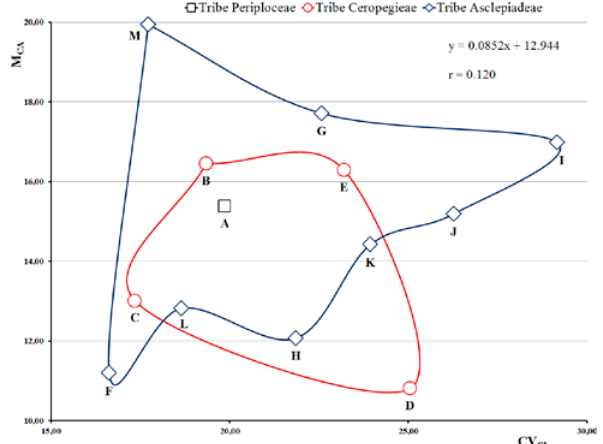
Figure 5. Scatter diagram between M CA and CV CL : Periploca angus- tifolia (A), Caudanthera edulis (B), Caudanthera sinaica (C), Desmi- dorchis acutangulus (D), Leptadenia arborea (E), Glossonema bove- anum (F), Solenostemma arghel (G), Pentatropis nivalis (H), Cynan- chum acutum (I), Calotropis procera (J), Gomphocarpus sinaicus (K), Pergularia daemia (L), Pergularia tomentosa